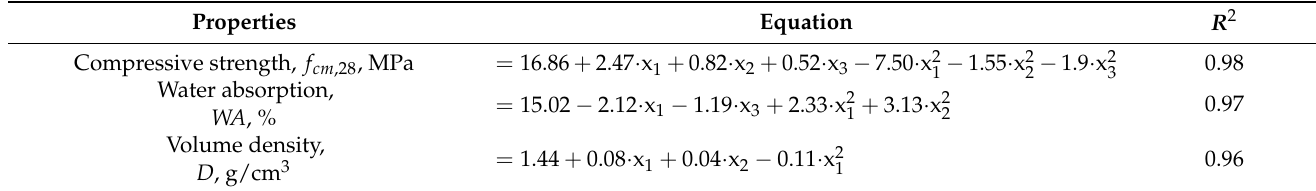
Table 9. Regression